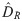
EU-emails: Normalized temporal differences for the resistance distance D^R, edit distance D^E, and DeltaCon distance D^DC.